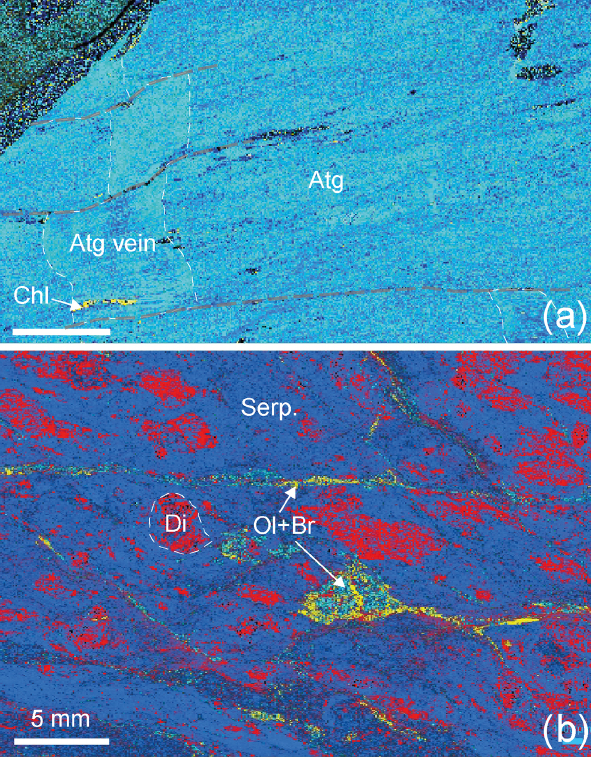
Figure 1. Raman maps of thin sections from high-pressure serpen- tinites of the Monviso area, Western Alps. (a) Foliated antigorite schists (sample Viso4) of nearly monomineralic composition (antig- orite (Atg): blue; minor chlorite (Chl): yellow; glass slide: black), with antigorite veins (dashed white lines) cross-cutting the folia- tion and shifted by late minor fractures (dashed grey lines). Varia- tions in the blue tone correspond to variations in crystal orientation and highlight the rock texture. (b) Weakly deformed serpentinite (Viso6) with complex mineralogy and texture partly preserved from the oceanic history, with former clinopyroxenes partly replaced by metamorphic diopside (Di) and chlorite, in a matrix of serpentine (Serp.), and olivine–brucite patches and veins (Ol +